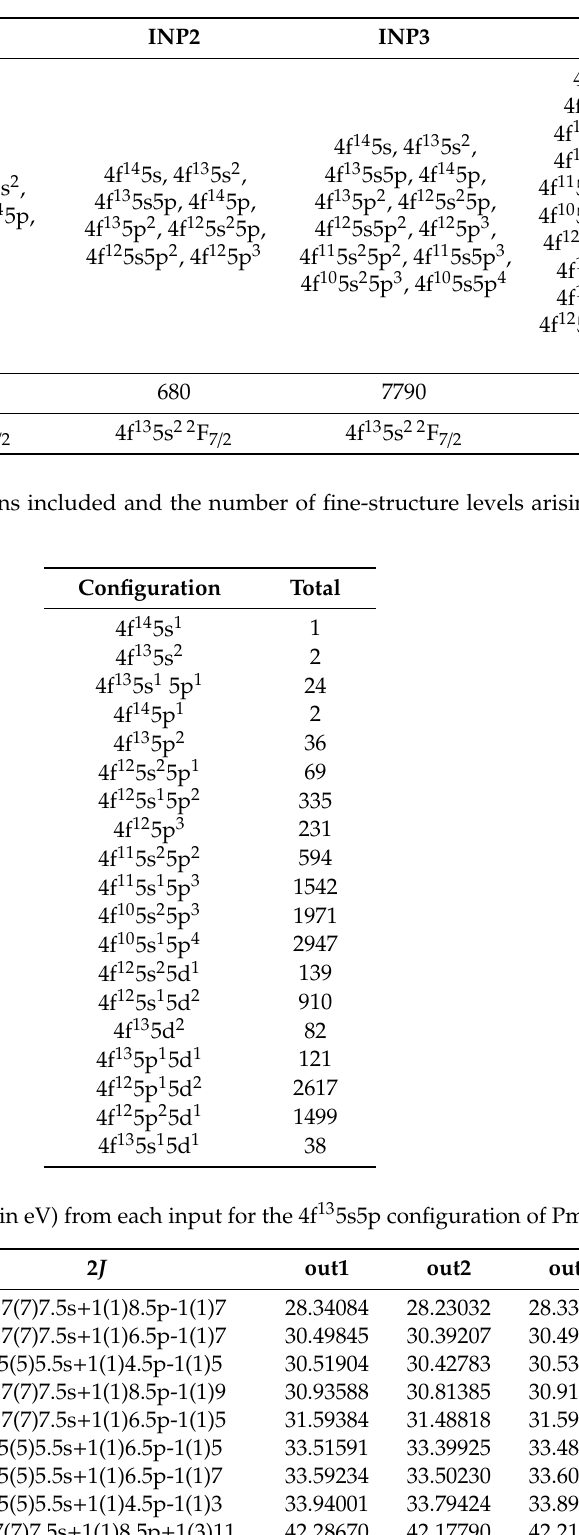
Table 7. Configurations included in the di ff erent inputs with the number of fine structure levels for Pm-like W.